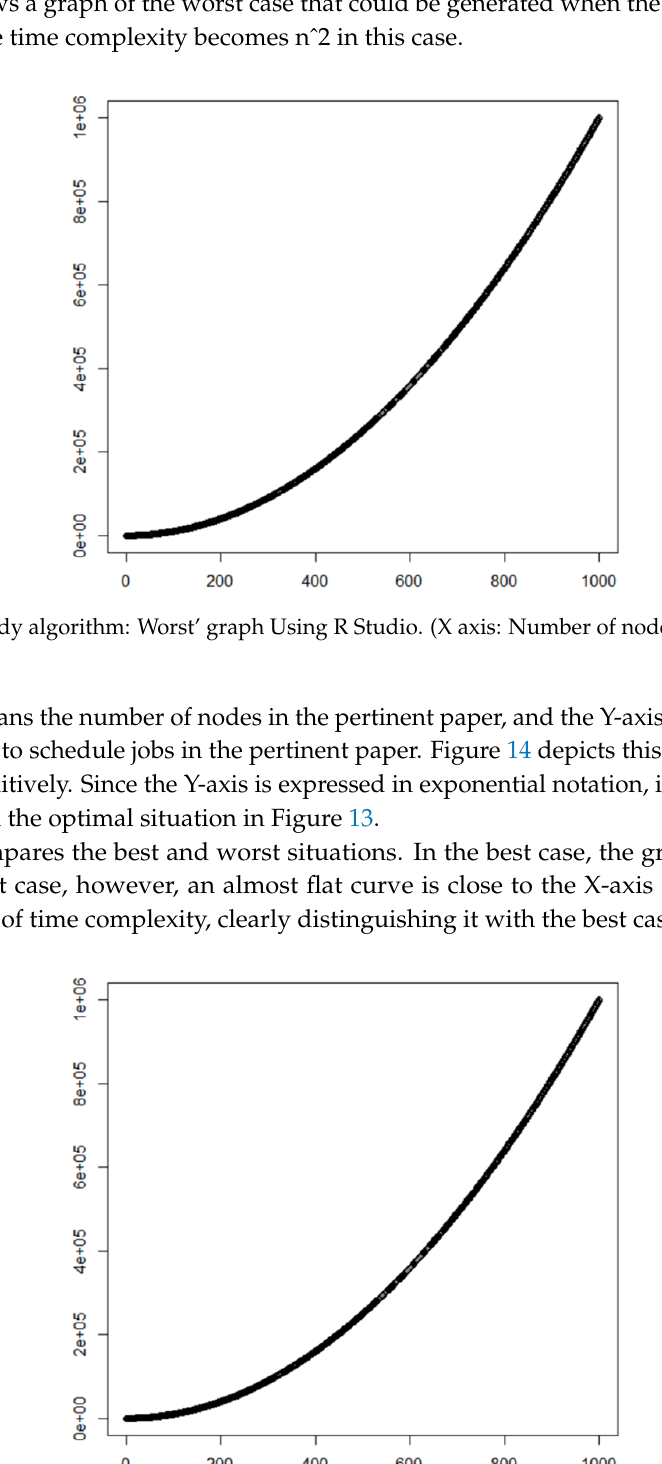
Figure 15. Comparison of ‘Greedy algorithm: Best/Worst’ Using R Studio. (X axis: Number of nodes, Y axis: Amount of calculation).